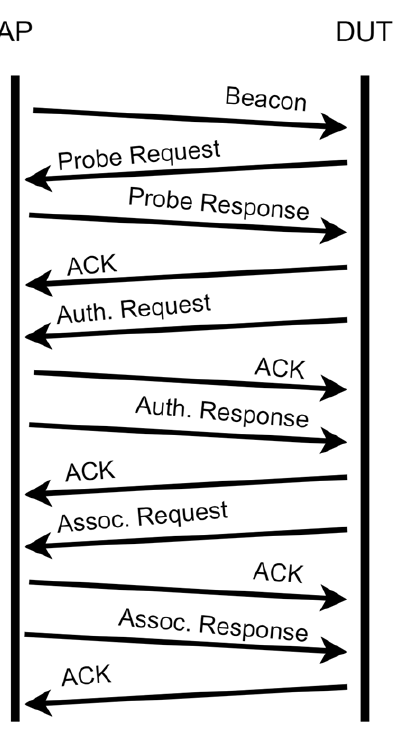
Figure 1. The 802.11 association process [18].